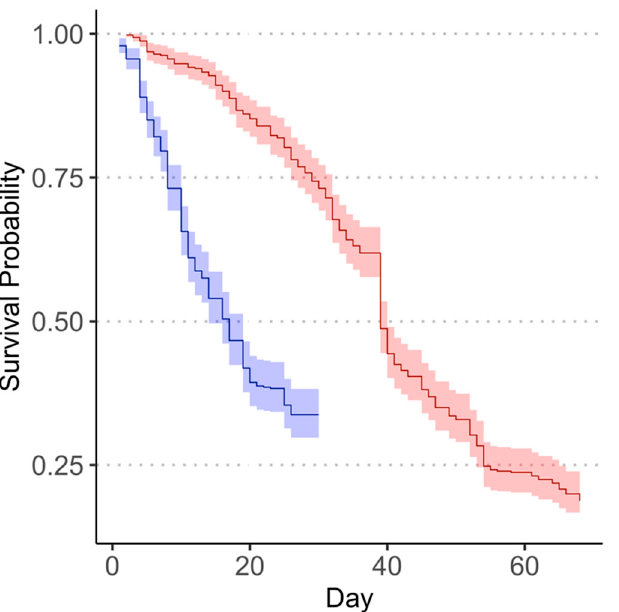
Figure 1. Survival curve showing differences in the instantaneous survival probability between the August (blue) and September (red) collections. Shaded areas represent 95% confidence intervals. Day zero represents the application of chemical treatments.